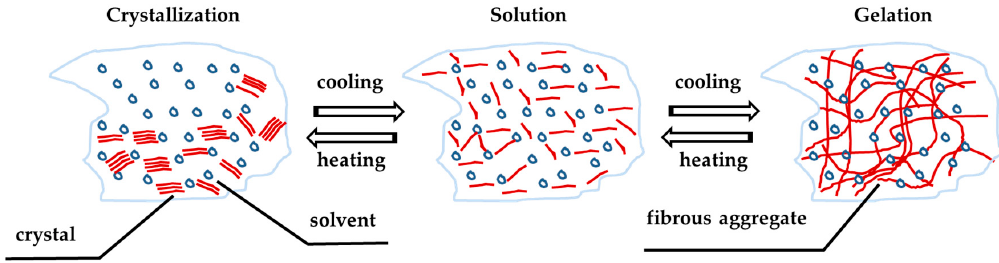
Figure 4. Organogel gelation–melting process representation.